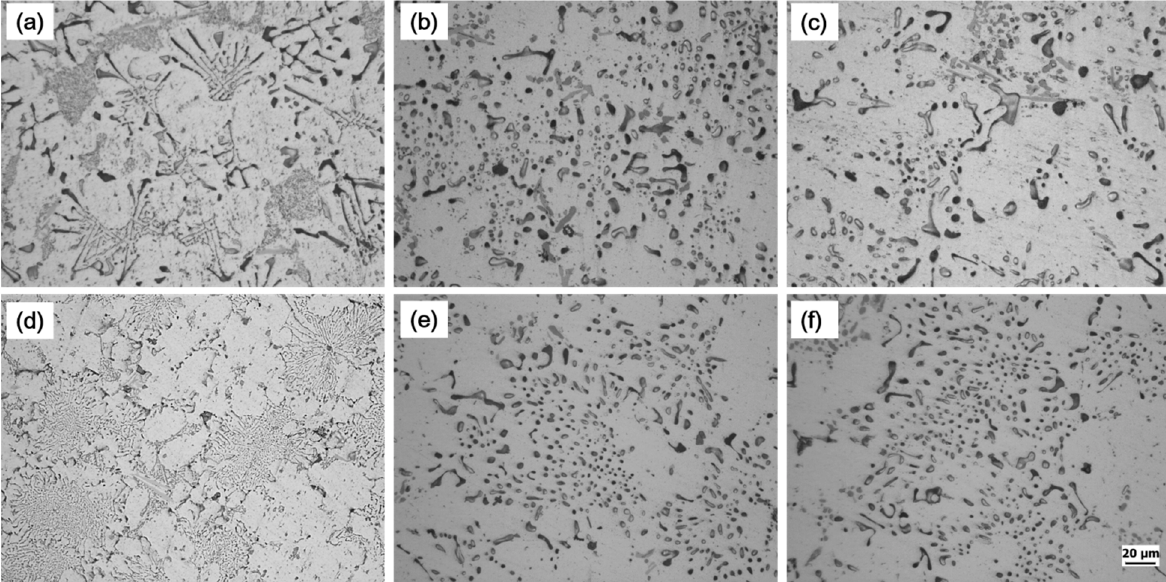
Figure 8. Optical microstructures of examined alloys in different temper conditions; ( a – c ) are respective microstructure of A1 alloy in as-cast-, SHT-, and T6-temper, whereas ( d – f ) are showing the microstructure of E1 alloy in as-cast-, SHT-, and T6-temper, respectively.